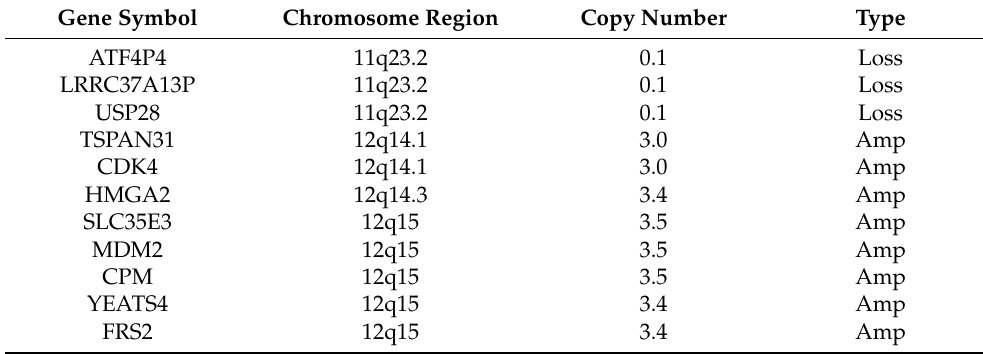
Table 2. Representative copy number alterations.